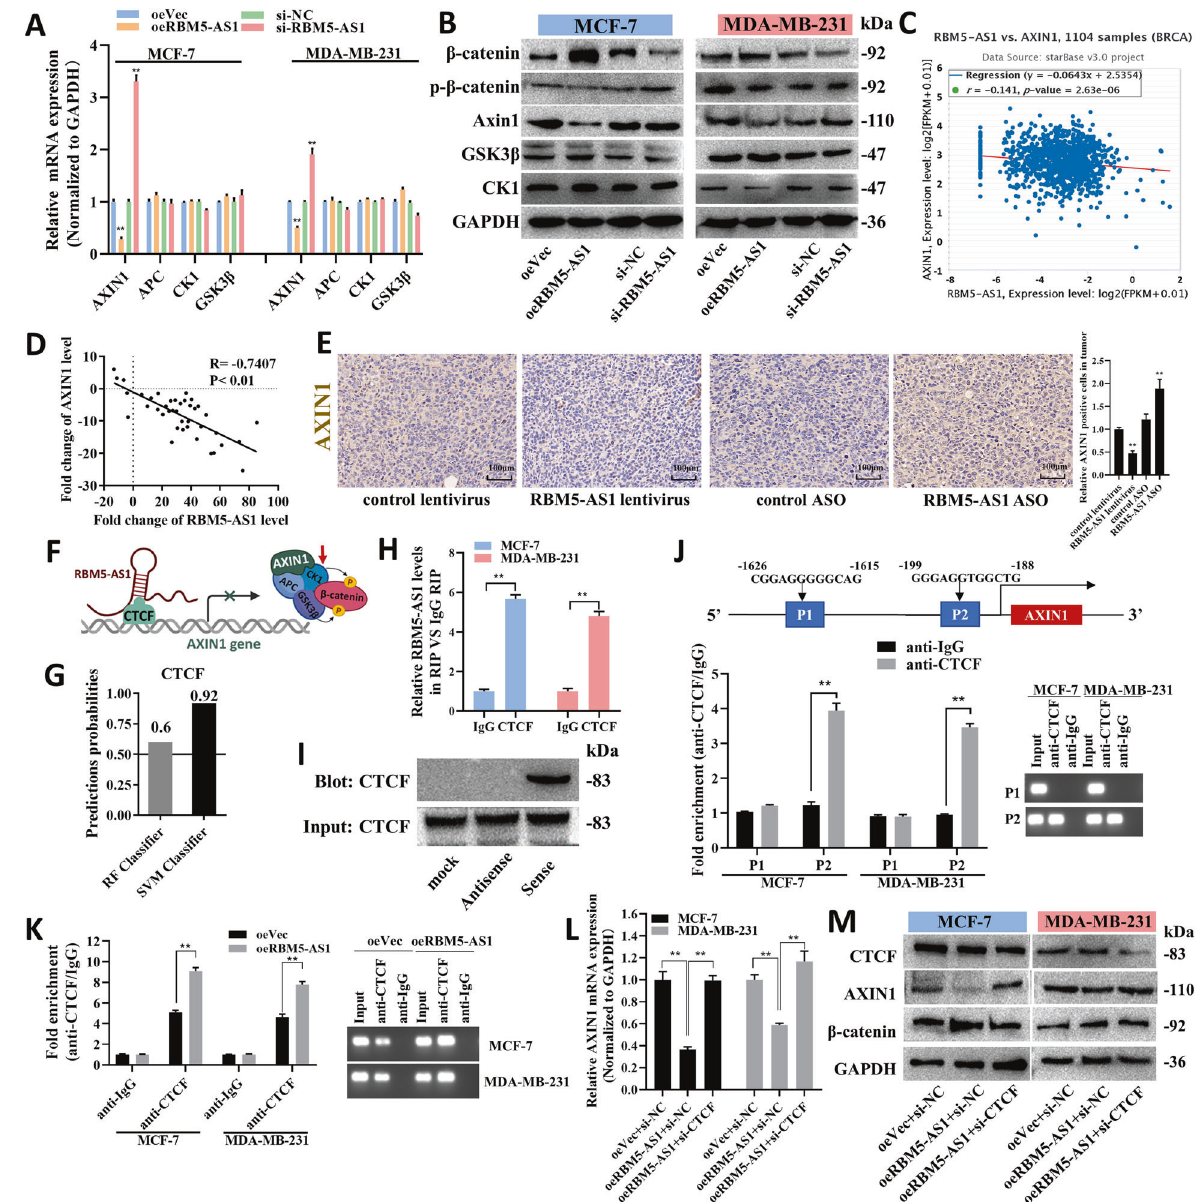
Fig. 6 RBM5-AS1 promotes accumulation of β -catenin through inhibiting a β -catenin destruction complex component, AXIN1. mRNA ( A ) and protein ( B ) levels of β -catenin destruction complex components in oeVec, oeRBM5-AS1, si-NC, or si-RBM5-AS1 transfected MCF-7 and MDA-MB-231 cells. C Spearman correlation analysis of RBM5-AS1 and AXIN1 mRNA levels in 1104 human breast cancer tissues according to the TCGA project extracted from StarBase 3.0. D The correlation between RBM5-AS1 and AXIN1 in 40 paired breast cancer tissues was analyzed with Spearman. E Representative images of AXIN1 IHC staining in mice tumor sections. Scale bar, 100 μ m. F Schematic diagram of the hypothesis that RBM5-AS1 inhibits AXIN1 expression by recruiting CTCF to the promoter region of AXIN1. G RPISeq software was used to predict the interaction probabilities of RBM5-AS1 and CTCF (RF and SVM > 0.5 were considered positive). H The interaction of RBM5-AS1 and CTCF was validated via RIP assays with CTCF antibody (IgG served as a negative control). I Proteins pulled down by biotin-tagged RBM5- AS1 sense or antisense were detected using CTCF antibody. J Putative CTCF binding sites at the AXIN1 promoter region (upper). Enrichment of CTCF on AXIN1 promoter relative to IgG in MCF-7 and MDA-MB-231 cells examined by ChIP assays (lower left) and PCR analysis (lower right). − 199 to − 188 bp fragment of the AXIN1 promoter contains the CTCF binding site. K Enrichment of CTCF on AXIN1 promoter relative to IgG in oeVec or oeRBM5-AS1 transfected MCF-7 and MDA-MB-231 cells was detected by ChIP-qPCR assays (left) and PCR analysis (right). AXIN1 mRNA levels ( L ), CTCF, AXIN-1 and β -catenin protein levels ( M ) in si-NC/oeVec or oeRBM5-AS1 or oeRBM5-AS1 plus si-CTCF transfected MCF-7 and MDA-MB-231 cells. All data are shown as the mean ± SEM. * P < 0.05 and ** P < 0.01 by two-tailed Student ’ s t -test. breast cancer tissues compared with non-BCSCs and paracancerous 132/212, respectively. RBM5-AS1 has also been demonstrated to normal tissues, respectively [6]. However, the expression and inhibit bone cell apoptosis and promoted fracture healing by function of RBM5-AS1 in breast cancer, and their underlying upregulating of β -catenin [17]. Previously, we detected that RBM5- regulatory mechanisms were still unknown. Thus, we fi rst veri fi ed AS1 was signi fi cantly increased in BCSCs and poorly differentiated